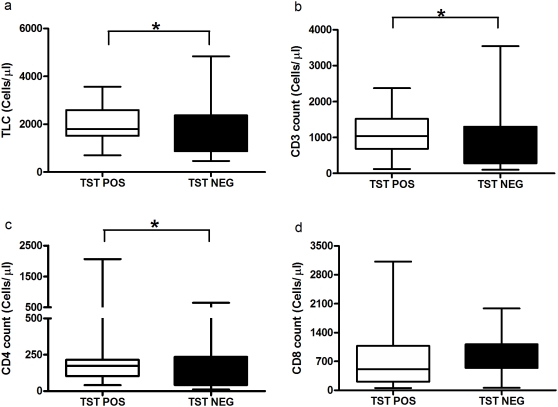
The level of total lymphocyte and T cell count in TST Positive and negative subjects.The level of total lymphocytes (a), CD3 count (b), CD4 count (c) were significantly low in TST negatives than TST positives whereas CD8 count (d) was not significantly different. Box and Whisker plots show range, inter-quartile range and median. TST – Tuberculin skin test, * significant difference p<0.05 by Mann-Whitney U test.